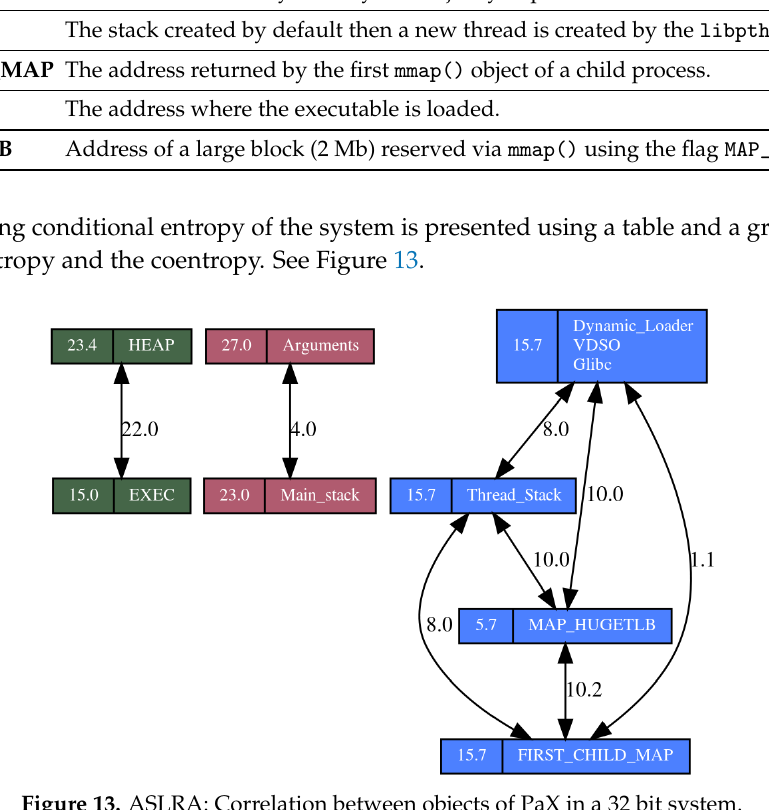
Figure 13. ASLRA: Correlation between objects of PaX in a 32 bit